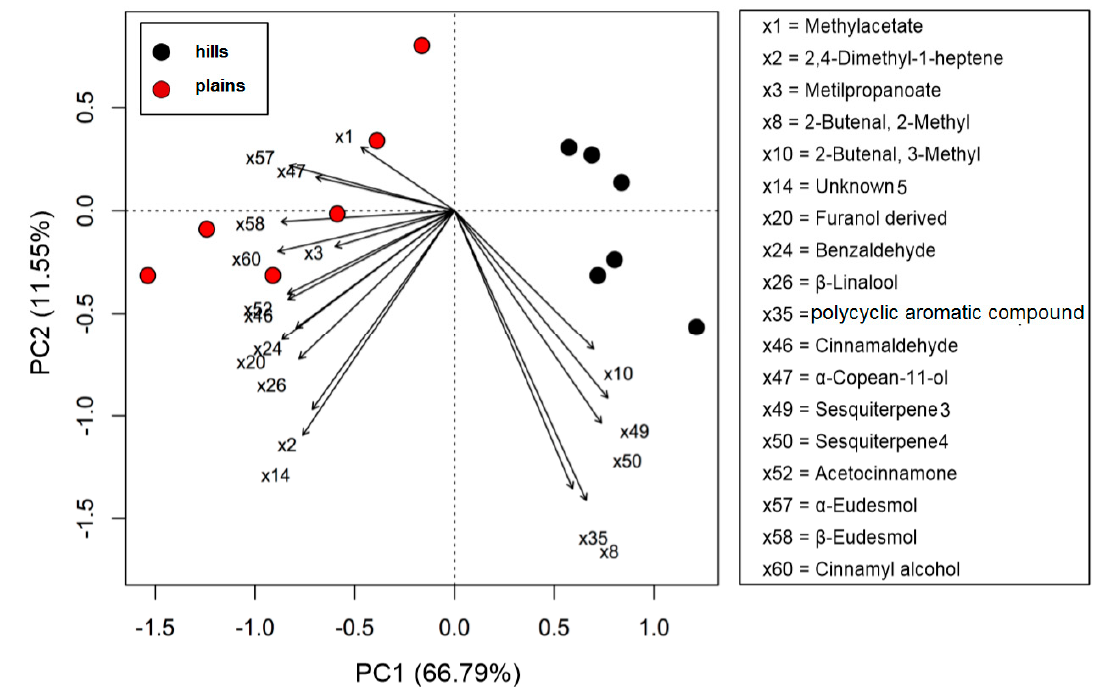
Figure 2. PCA biplot of volatile compounds (VOCs) of propolis samples collected in hills (Ligurian–Piedmont Apennines) and plains (Po Valley).